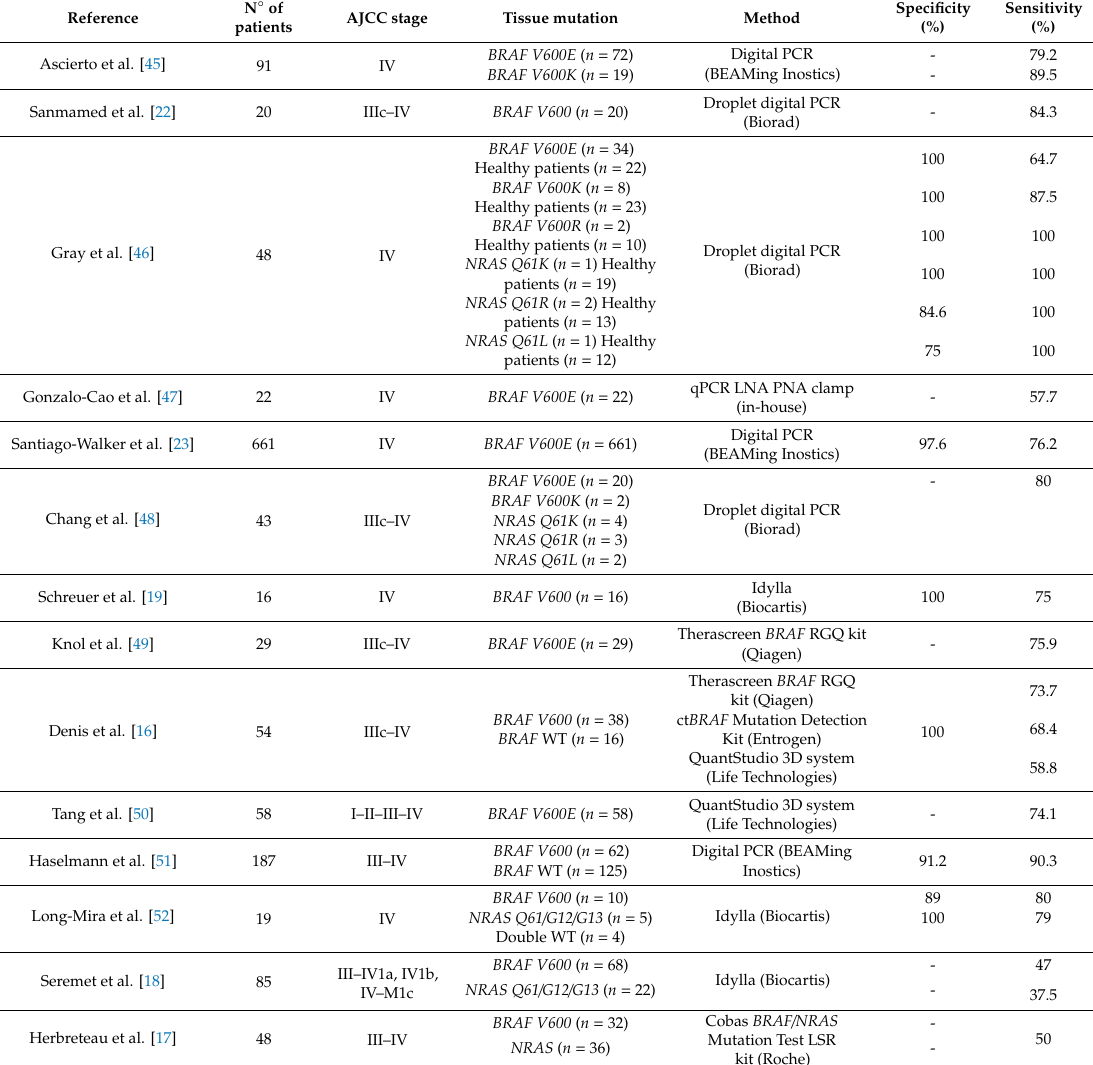
Table 2. Diagnostic performance of detecting BRAF and NRAS mutations in plasma using quantitative real-time PCR and emulsion-PCR-based